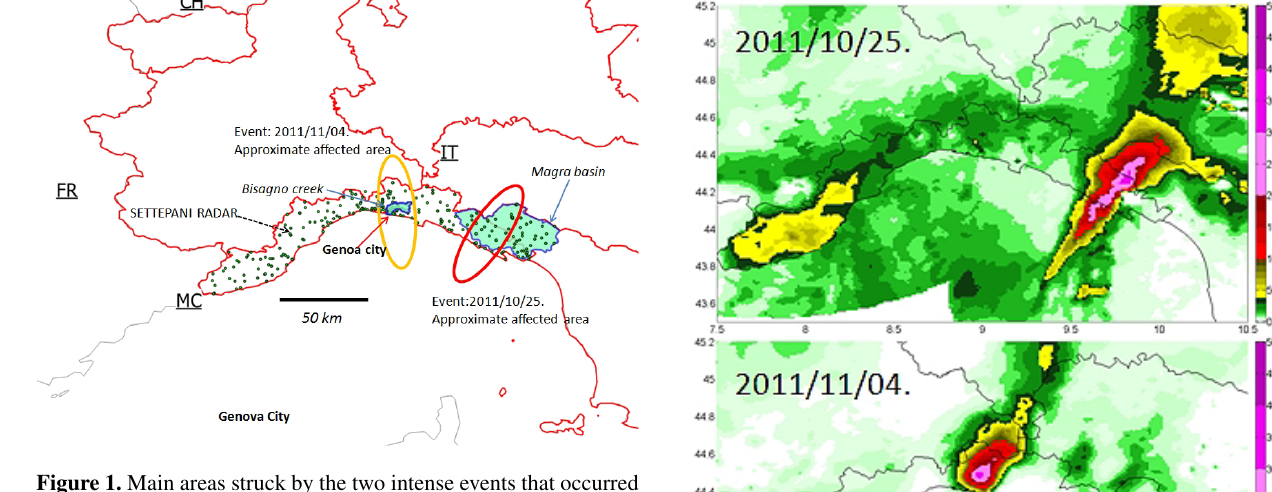
Figure 1. Main areas struck by the two intense events that occurred between October and November 2011 (red and yellow ellipses). The watermarks of the Bisagno creek and of the Magra basin are re- ported in blue. The green dots are the rain gauges of the regional network. Red lines represent the regions in northwestern Italy.